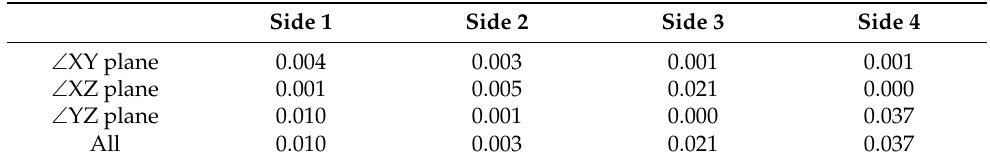
Table 2. Side angle error of the FCP (unit: ◦